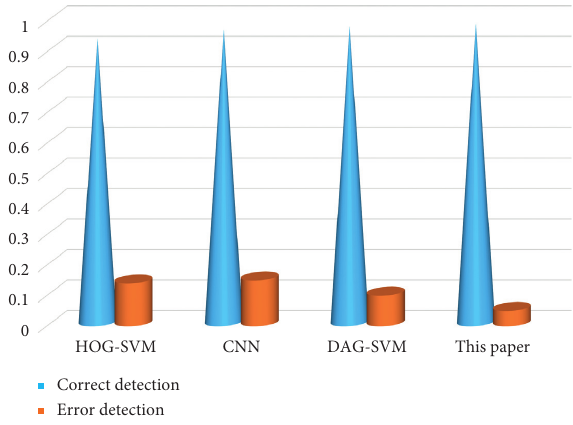
Figure 8: Test results in INRIA dataset.